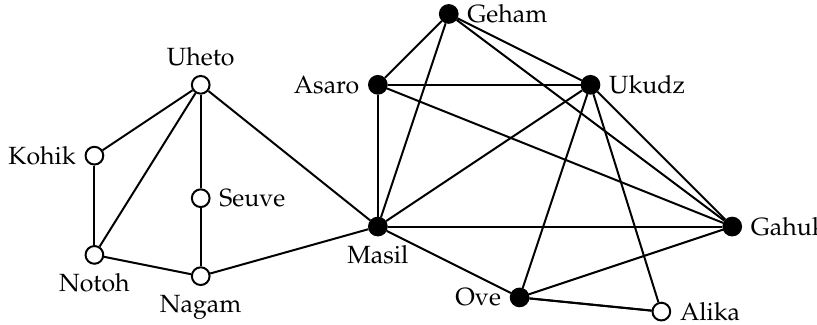
Figure 6. A part of the highland tribes social network [4]. The black vertices form the maximum 0.5-relative-vertex-connected set in this network. This set is also a maximum-0.5-relative-vertex-connected set, but it is not highly